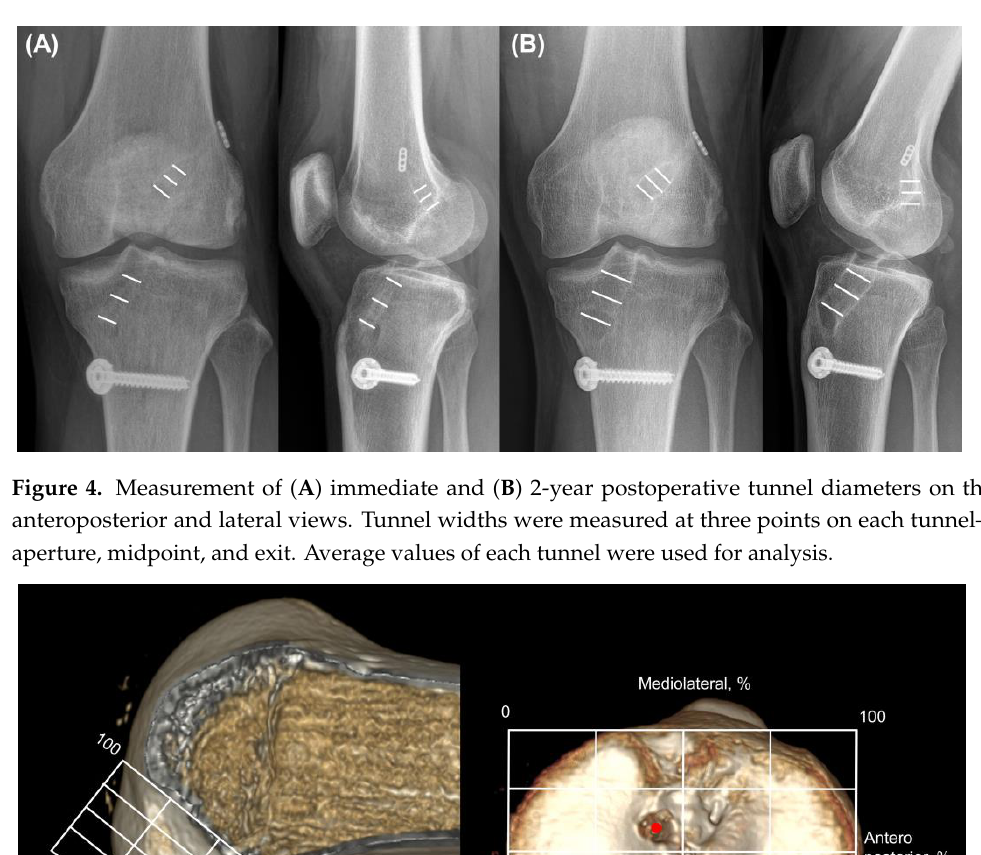
Figure 4. Measurement of ( A ) immediate and ( B ) 2-year postoperative tunnel diameters on the an- teroposterior and lateral views. Tunnel widths were measured at three points on each tunnel — ap- erture, midpoint, and exit. Average values of each tunnel were used for analysis.